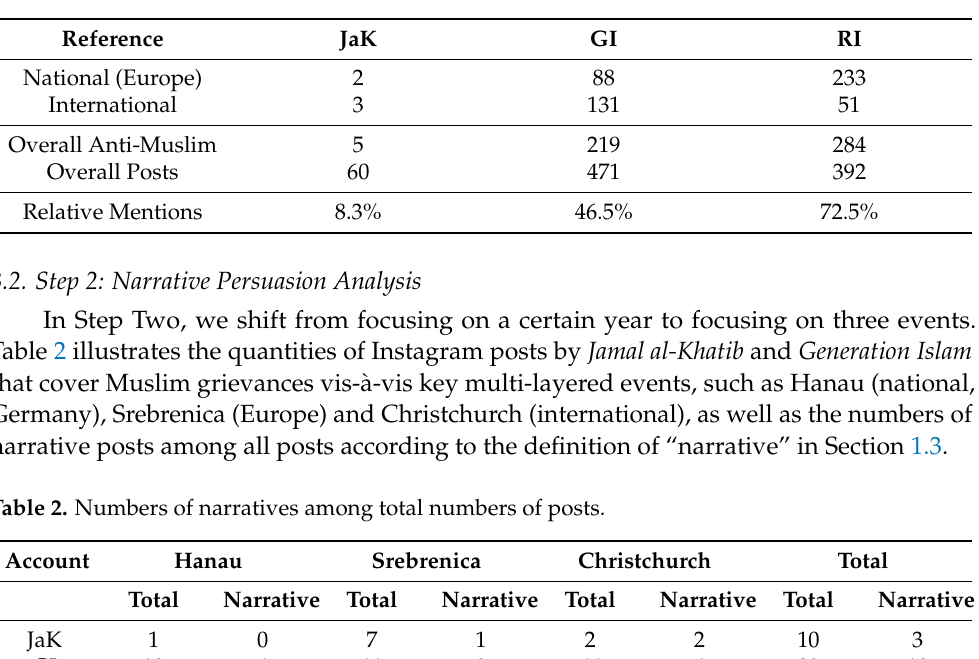
Table 1. Relative Mentions of Muslim grievances in 2021.